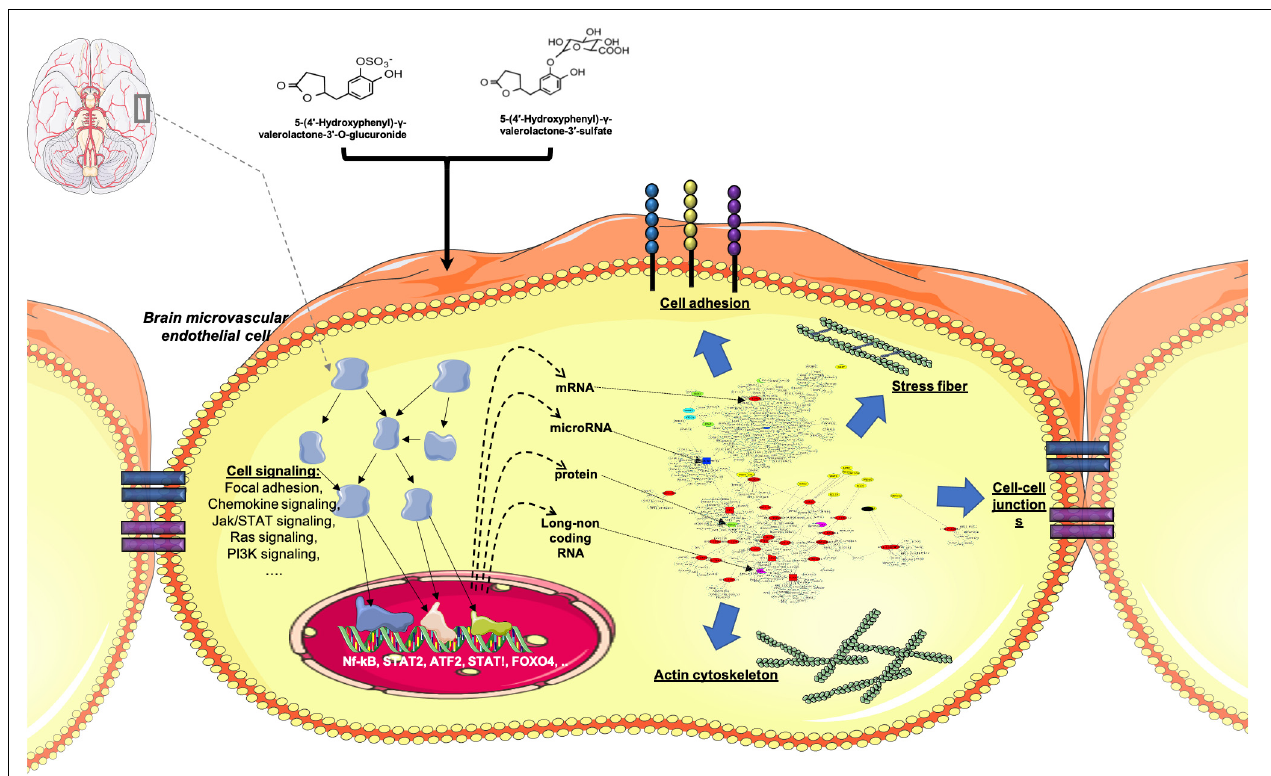
FIGURE 11 | Conceptual summary of genomic modification of γ -valerolactones in human brain microvascular endothelial cells. Differential expression of protein-coding genes, microRNAs, lncRNAs, and proteins that could regulate cellular processes such as those regulating brain microvascular endothelial cells permeability. Adapted from